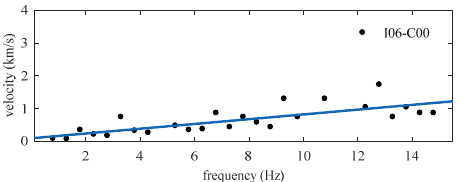
Figure 16. Seismic velocity at different frequencies.